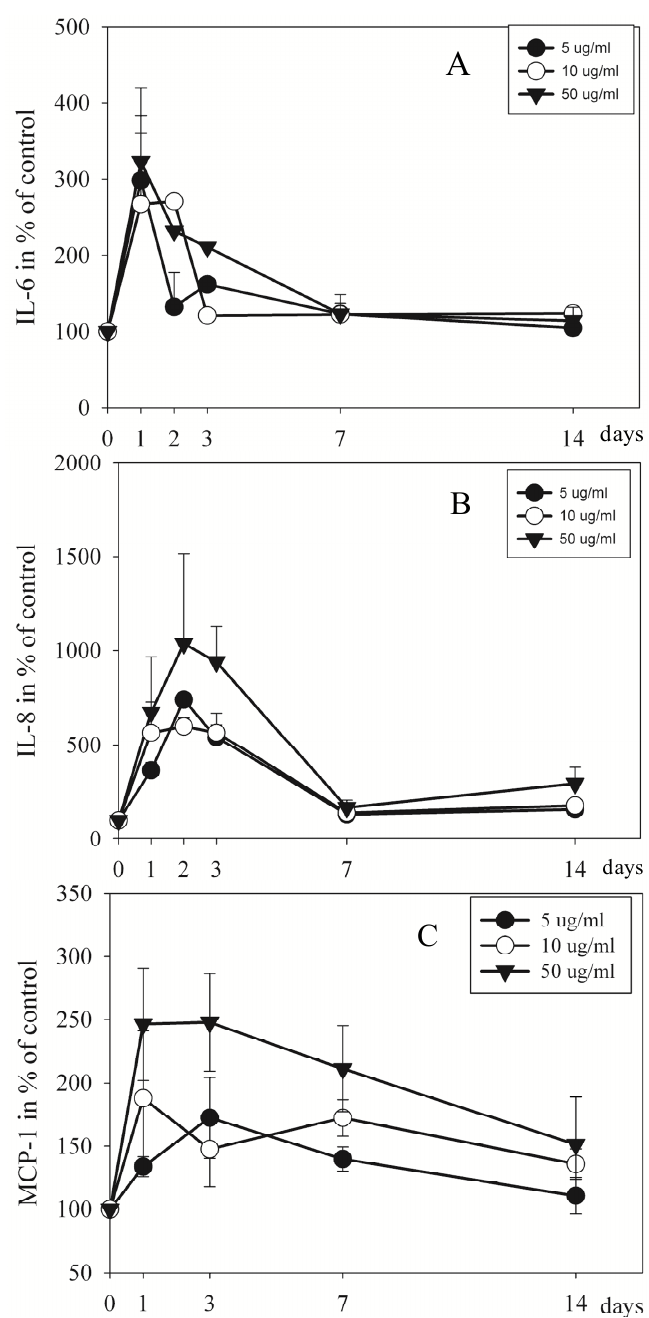
Figure 3. The effect of 5, 10, 50 μ g/mL of EMD on the concentration of IL-6 ( A ); IL-8 ( B ); and MCP-1 ( C ) in the cell culture medium. The data are presented as mean ± SD and calculated in percent of untreated cells (100%) at each time